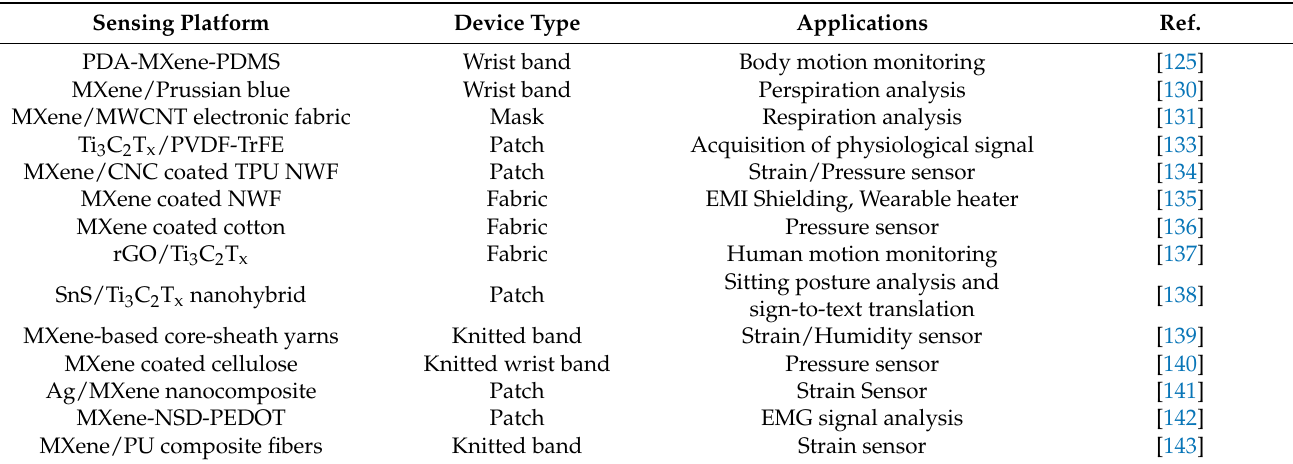
Table 4. Literature reports on the MXene-based smart